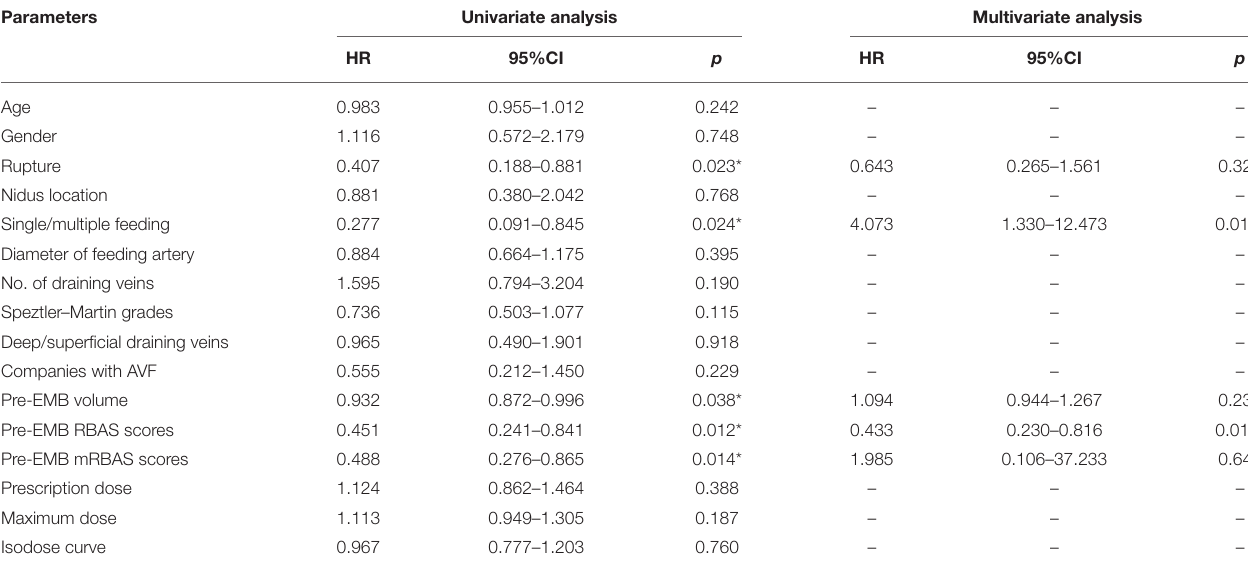
TABLE 2 | COX regression analysis of factors associated with obliteration in combined treatment group. Parameters